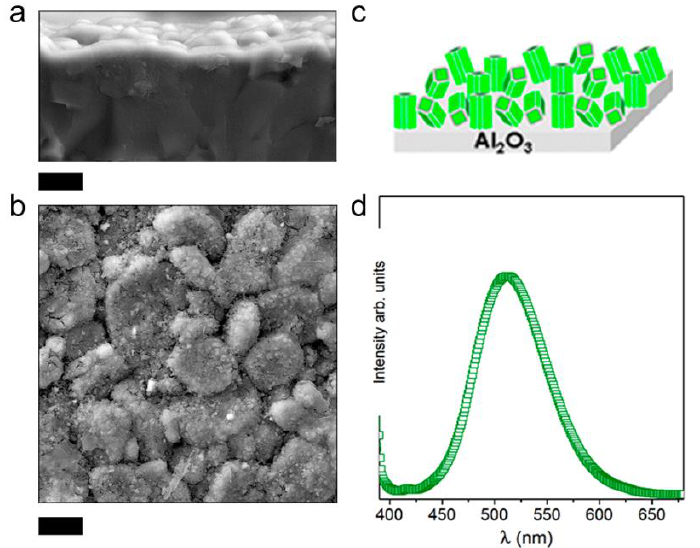
Figure 11. Field-emission scanning electron microscopy (FE-SEM) micrographs of the SrAl 2 O 4 :Eu, Dy, films obtained over polycrystalline alumina substrate: ( a ) cross-section and ( b ) surface view. ( c ) Scheme of the growth of the film over a polycrystalline substrate. ( d ) Emission spectra of the SrAl 2 O 4 :Eu, Dy, film obtained by screen printing. The scale bar in ( a , b ) represents 5 µm.